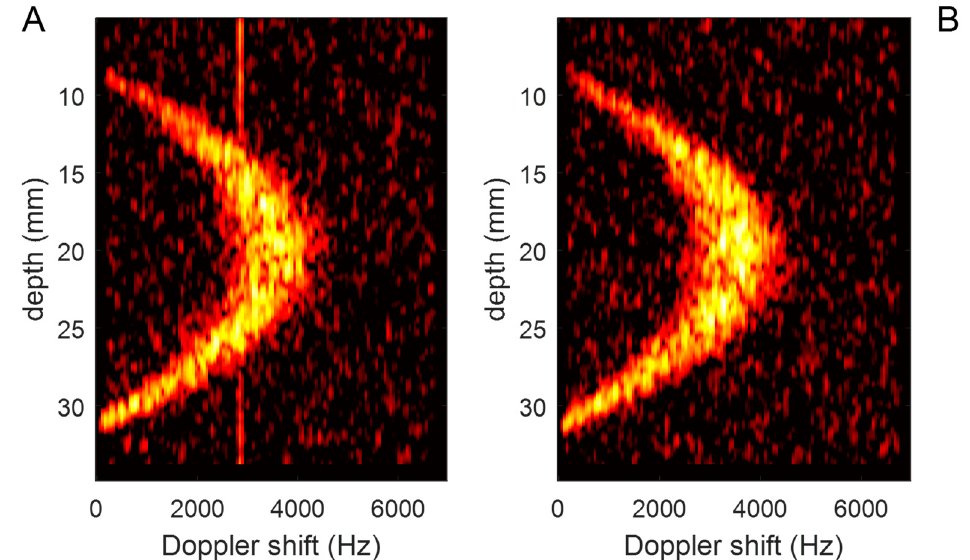
Figure 9. Doppler spectral matrices processed by the system when the power regulator is modulated by a triangle frequency. ( A ) Condition in Equation (21b) is not verified. ( B ) Condition in Equation (21b) is verified.